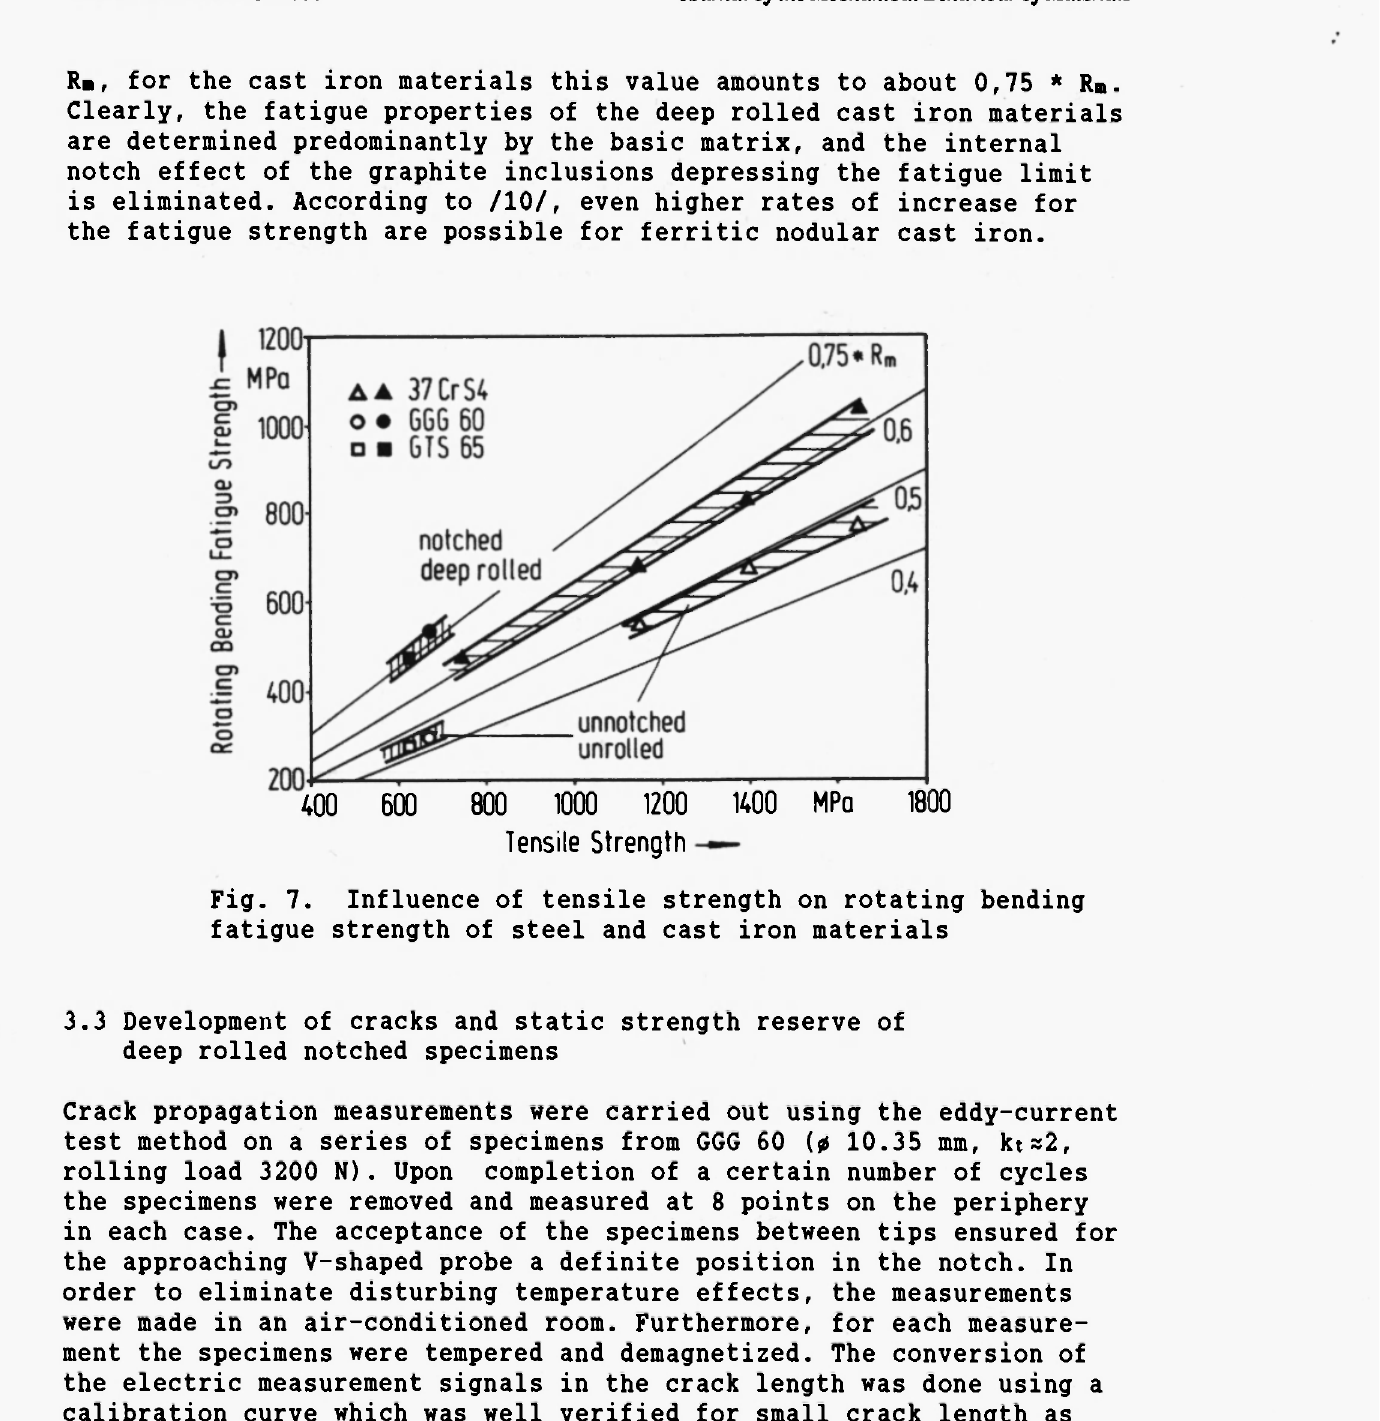
Fig. 7. Influence of tensile strength on rotating